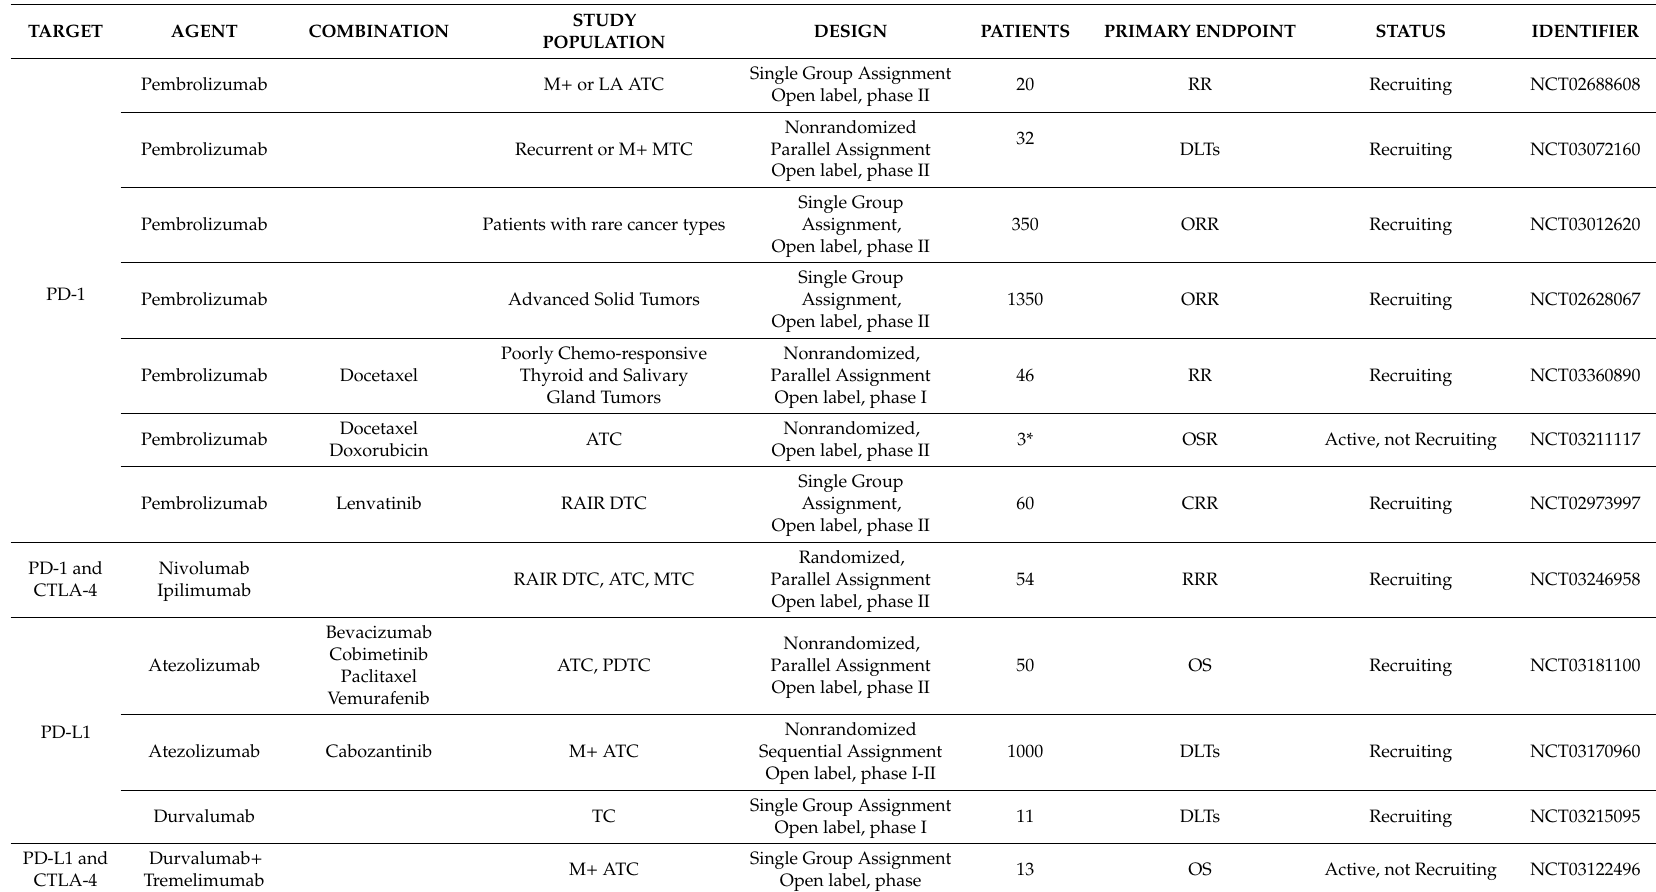
Table 4. Clinical trials with immune checkpoint